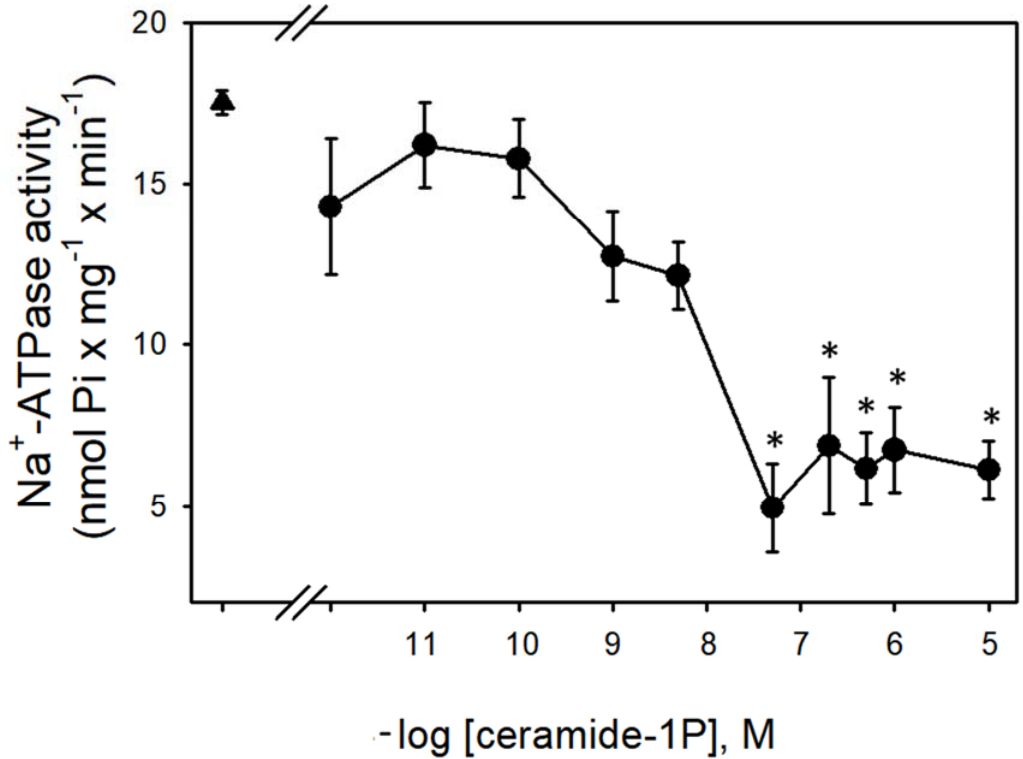
Figure 1. Ceramide-1-phosphate inhibits BLM Na + -ATPase activity. Na + -ATPase activity assays were performed in the presence of crescent C1P concentrations shown on the abscissa (see details in Material and Methods). Data are means ± SE of at least six experiments conducted in triplicate with different kidney BLM preparations. Triangle: control without C1P. * Significantly different from the control ( p < 0.05).